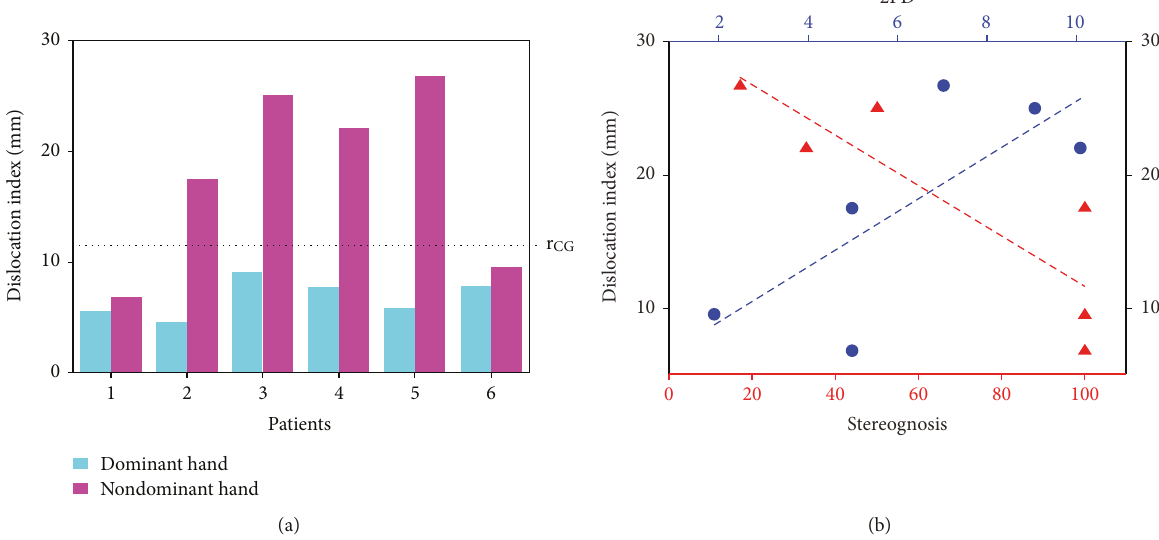
Figure 4: (a) Dislocation indices for nondominant (pink bars) and dominant (cyan bars) hands. All dominant hand S1 dislocation indices are inferior to the radius, r CG (expected localization according to the control group analysis) as well as 2 out of 6 nondominant hand indices. The latter are of the 2 subjects with no sensory de fi cit (see Table 1 for clinical details). (b) Correlation between dislocation index and sensory de fi cit assessed at 2PD and stereognosis. A signi fi cant correlation emerged between dislocation index and sensory de fi cit, with a greater distance being associated to a worse sensory de fi cit. Abbreviation: 2PD: 2-point